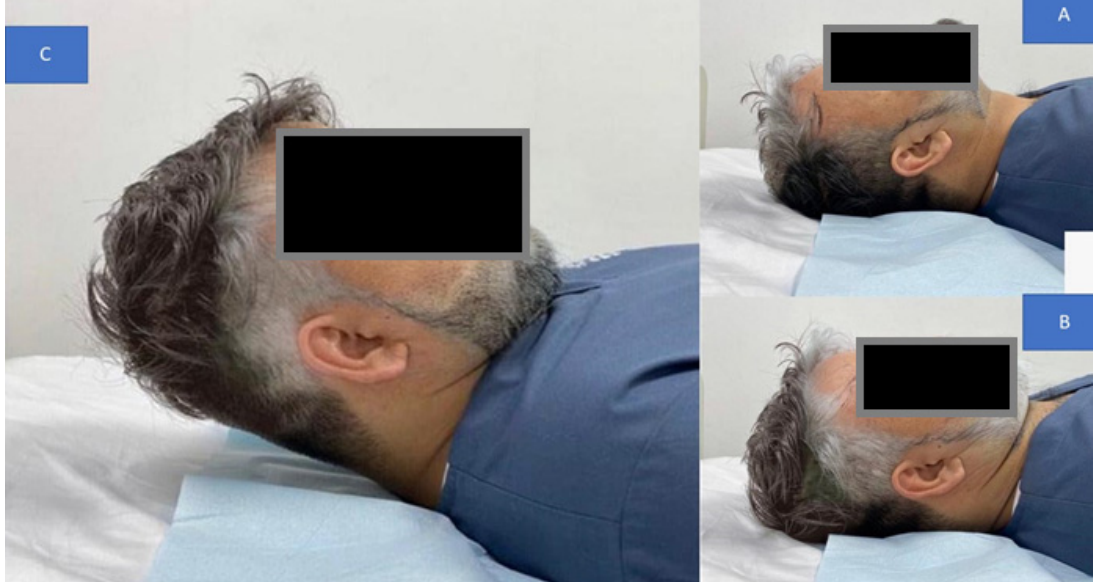
Figure 4. The chin tuck exercise: ( A ) starting position; ( B ) chin tucks performed while lying supine with the posterior aspect of the skull in contact with the floor; ( C ) the head is then lifted off the floor in a tucked posture.